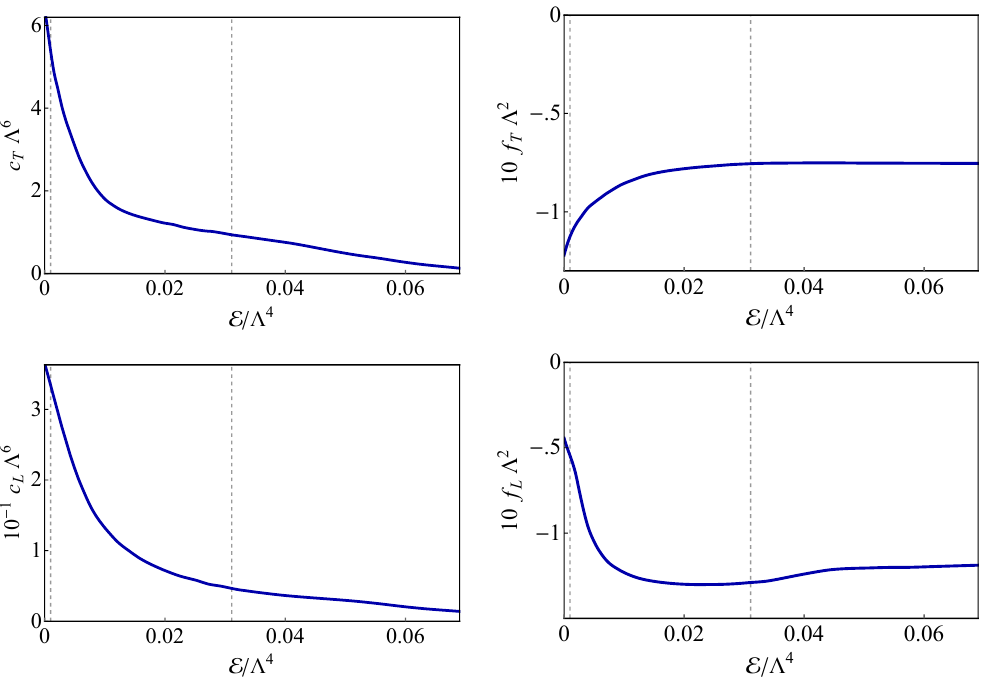
Figure 30 . Second-order coe(cid:14)cients entering the purely-spatial formulation of hydrodynamics as a function of the energy density. The grey vertical lines indicate the values at which the speed of sound crosses zero (see (cid:12)gure 2(left)).